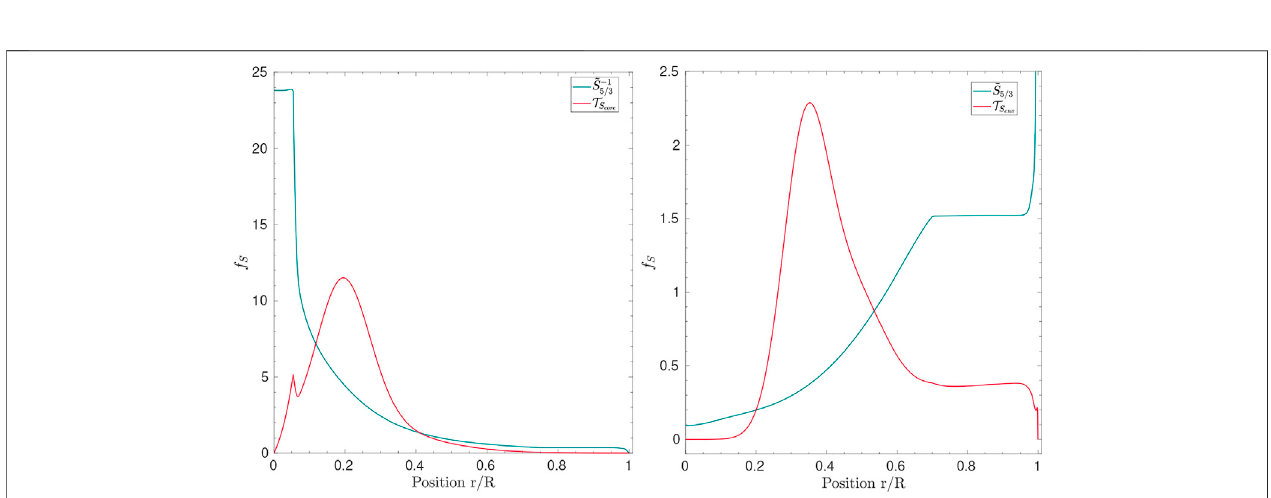
FIGURE10 | Left : target function ofthe S core indicator and normalized inverse pro fi le of S 5/3 as afunction ofnormalized radius for a1.07M ⊙ harboring aconvective core. Right : target function of the S env indicator and normalized pro fi le of S 5/3 as a function of normalized radius for a solar model [adapted from Buldgen et al. (2018)].